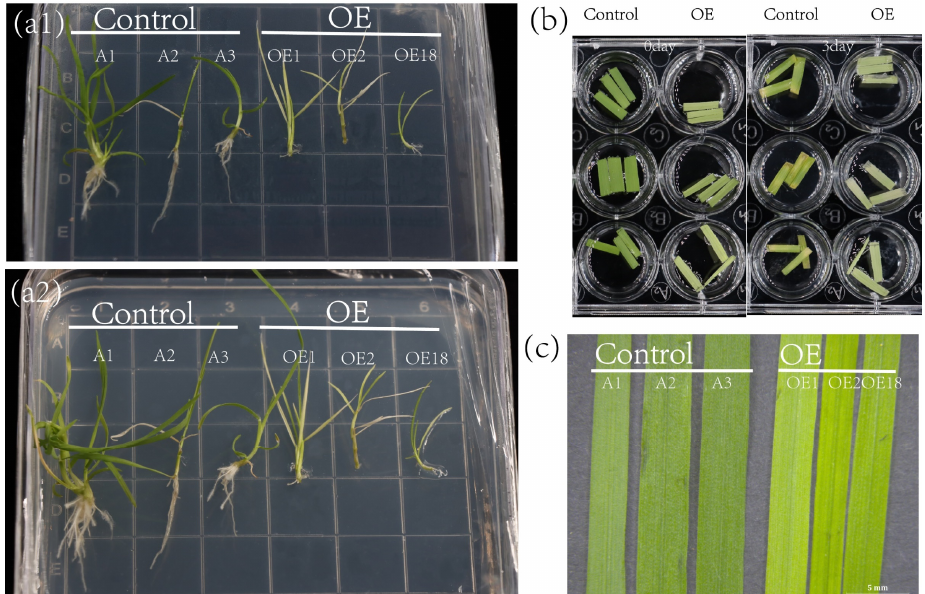
Figure 8. Leaf yellowing phenotype of transgenic creeping bentgrass. ( a1 , a2 ) Comparison of trans- genic creeping bentgrass (OE) and control on a MS plate. ( b ) Detached leaves of OE and control at 30-days-old were soaked in 3 mM MES for 0 or 3 days. ( c ) Comparison of the phenotypes of transgenic creeping bentgrass and control at 30 days. Ferro green was used to stain the leaves of the control and transgenic plants, while ferro red was used to stain the cell walls, which were rich in cellulose. In the leaves of the transgenic plants, cortex tissue thickness and cell length were increased. The cortex of transgenic plants was thicker and the vascular column cells were smaller than those in the